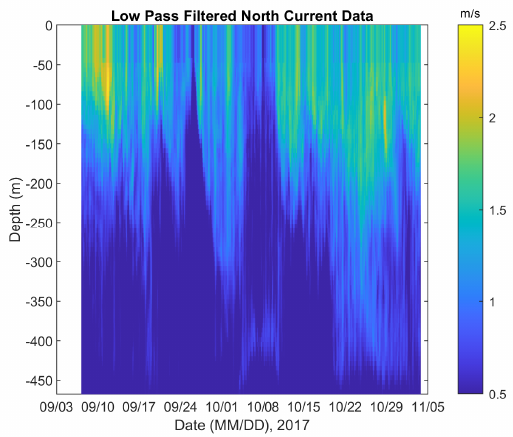
Fig. 3. Northward component of current velocity recorded by a 75 kHz ADCP after filtering out ”bad” data, extrapolating data vertically, and low pass filtering these data at 1-hour